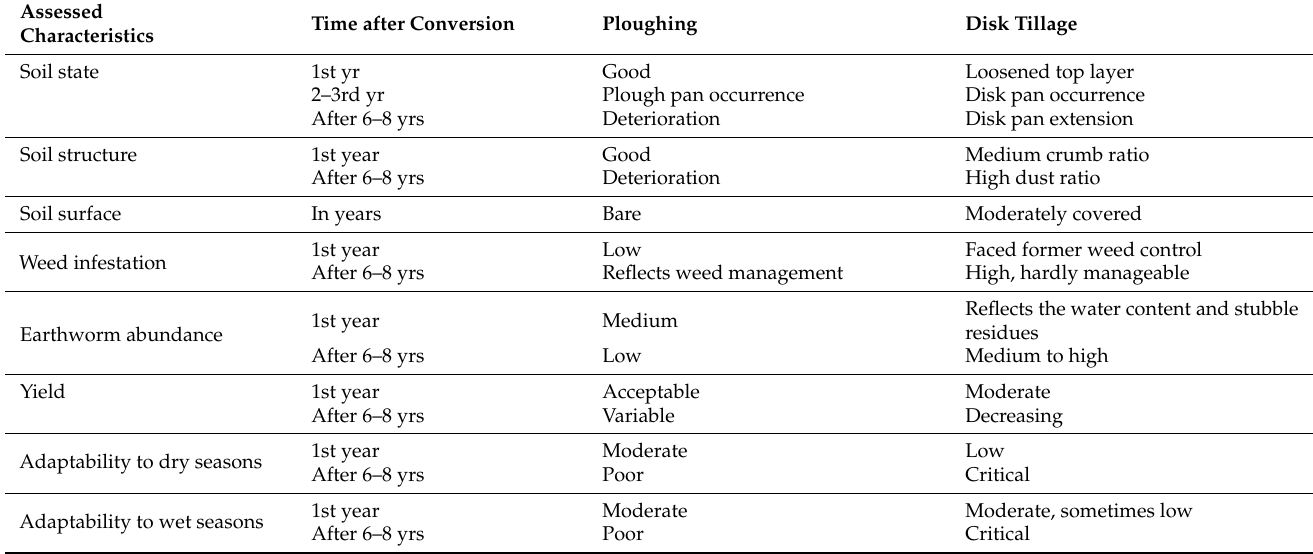
Table 3. Evaluation of ploughing and disk tillage in the first years and in the long term based on Birk á s